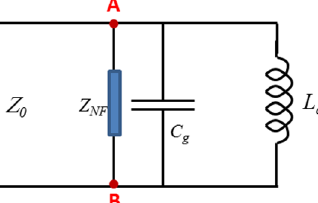
Fig. 6. Small signal model of the MOSFET [37]. The three nodes correspond to the Gate (G), Source (S), and Drain